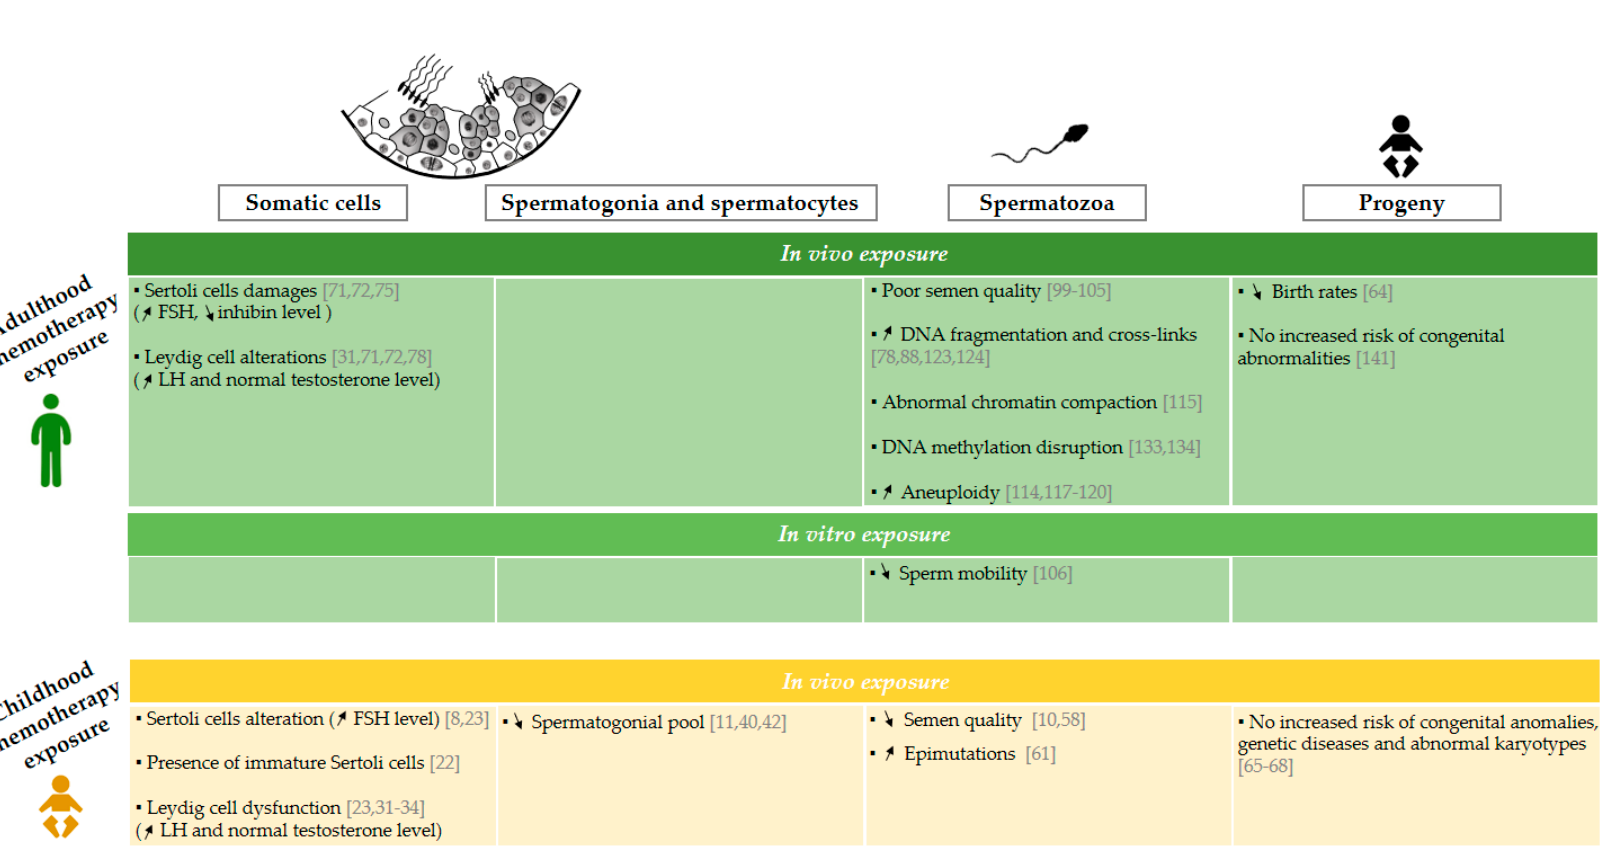
Figure 1. Effects of chemotherapy exposure during adulthood and childhood on men fertility. Schematic representation of epidemiological data available on the impact of the administration of chemotherapy on somatic cells [8,22,23,31–34,71,72,75,78], spermatogonia and spermatocytes [10,40,42], spermatozoa [10,58,61,78,88,99–106,114,115,117–120,123,124,133,134], and progeny [64–68,141] following chemotherapy administration during childhood and adulthood. “Childhood chemotherapy exposure” is defined as the administration of cancer treatment during infancy and adolescence period too. The arrows ↗ and ↘ indicate an increase and a decrease respectively. FSH: follicle stimulating hormone, LH: luteinizing hormone, SSC: spermatogonial stem cell.